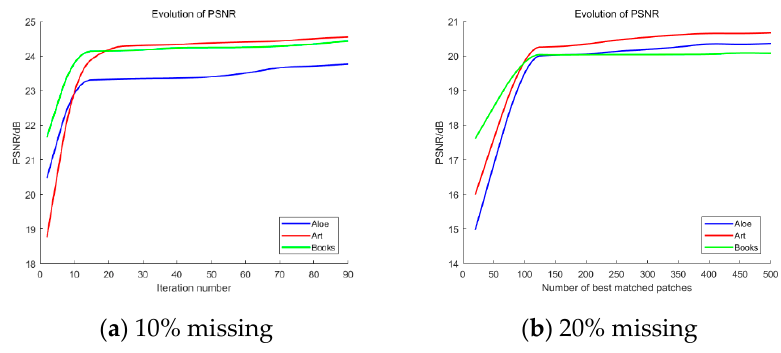
Figure 7. Stability of the proposed algorithm.